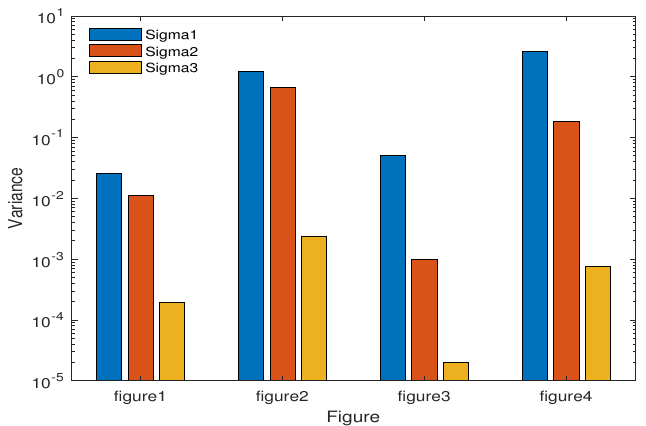
Figure 8. Parameter